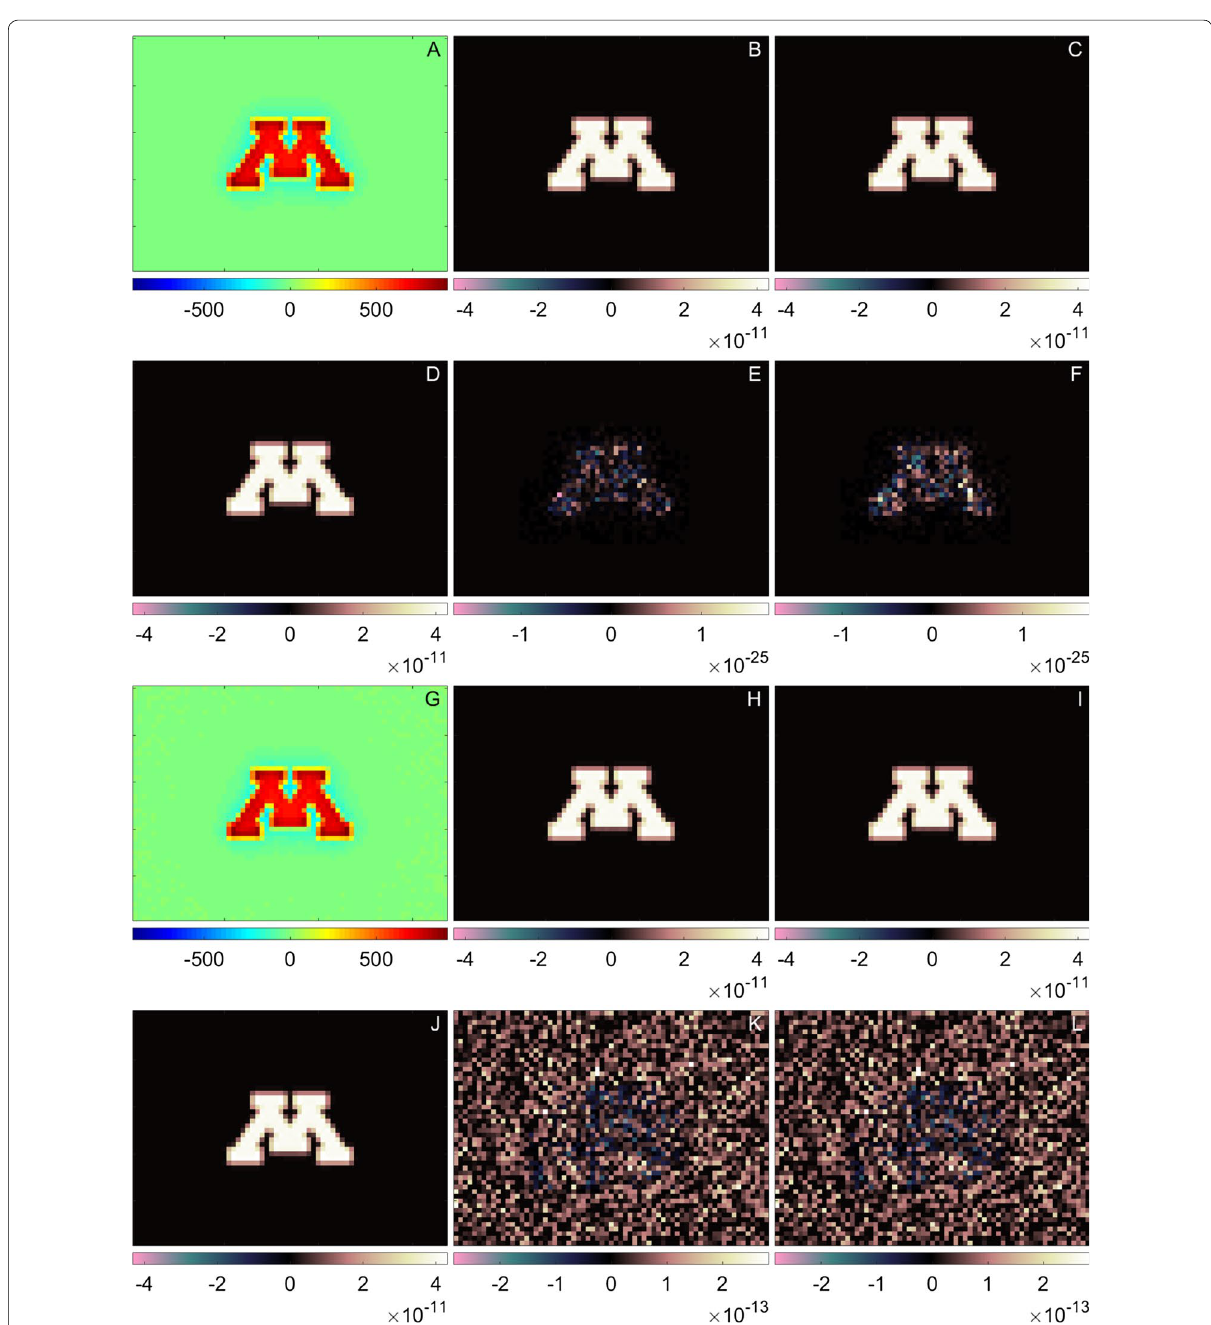
Fig. 2 Comparison of SIRM magnetic sources for synthetic MM data of the UMN logo for scenarios 1 ( a – f ) and 2 ( g – l ): a , g simulated synthetic SIRM B z field in nT calculated from the UMN logo, b , h inverted magnetic sources from the TNT-NN method, c , i inverted magnetic sources from the LH-NNLS method, d , j known magnetic sources used to produce the synthetic MM scan (negative values are difficult to discern as their magnitudes are approximately an order of magnitude less than the positive values), e , k difference between the TNT-NN and known solutions, f , l difference between the LH-NNLS and known solutions. The field of view for each image is 6.7 mm × 5 mm, dipole orientation is out of page, and the units of b – f and h – l are Am